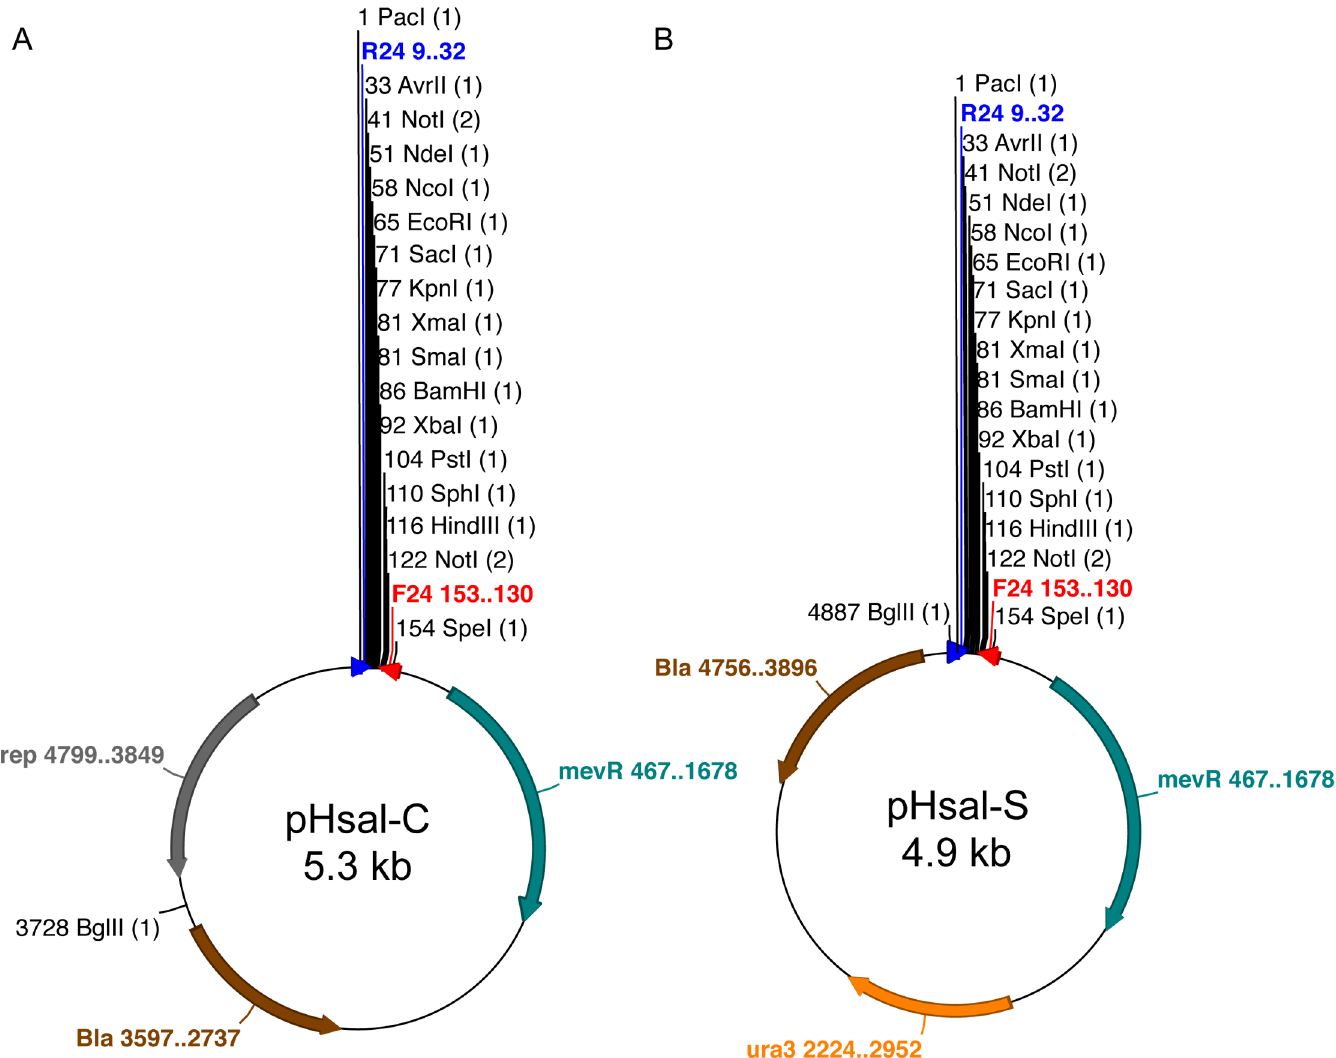
Fig 3. Physical maps of the modular cloning (pHsal-C) and suicide (pHsal-S) vectors. The main features of the vectors are represented, along with their relative positions. (A) pHsal-C is formed by the cargo, a mev R resistance marker and an origin for autonomous replication in H . salinarum , while (B) pHsal-S is endowed with a mev R and an ura3 marker and is devoid of replication origins for this archaeon. Yet, both vectors have the fragment with the Ap R resistance marker ( bla gene) and the ColE1 replication origin for replication and selection in E . coli